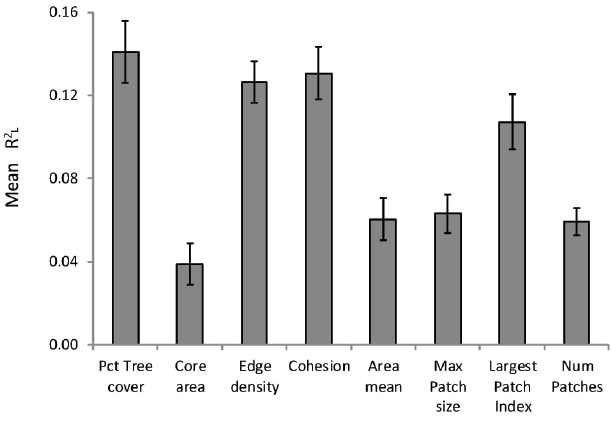
Fig. 2 . Average response and standard error (vertical lines) among 22 grassland species to 8 landscape fragmentation metrics, where the response variable was likelihood of occurrence. All transect segments were used in these averages. (Data from Cunningham and Johnson 2011; for metric definitions, see McGarigal et al.